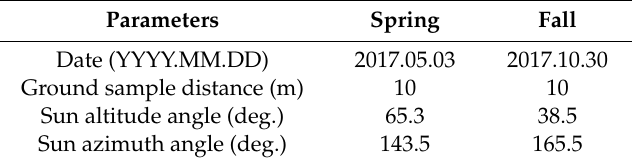
Figure 4. Sentinel-2 satellite ortho-rectified images acquired in the study area: ( a ) spring season; and ( b ) fall season. Table 1. Parameters of Sentinel-2 images used in this study.